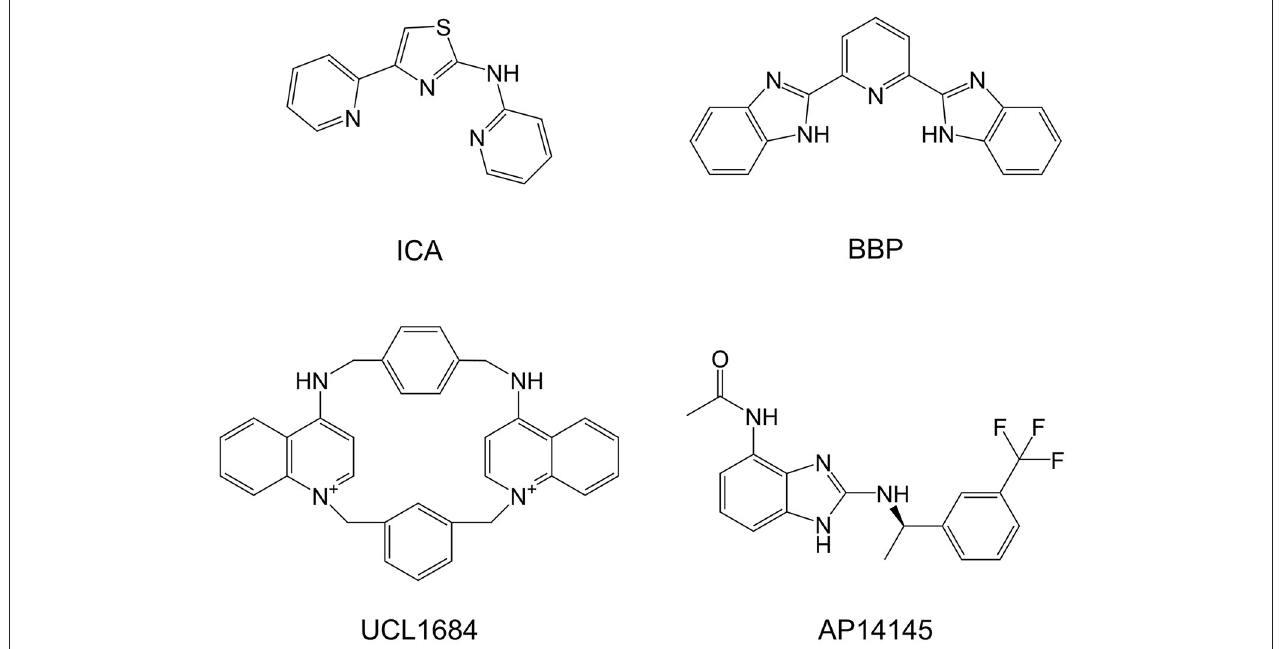
FIGURE 1 | Chemical structures of SK blockers UCL1684 and ICA, SK negative allosteric modulator AP14145, and BBP.